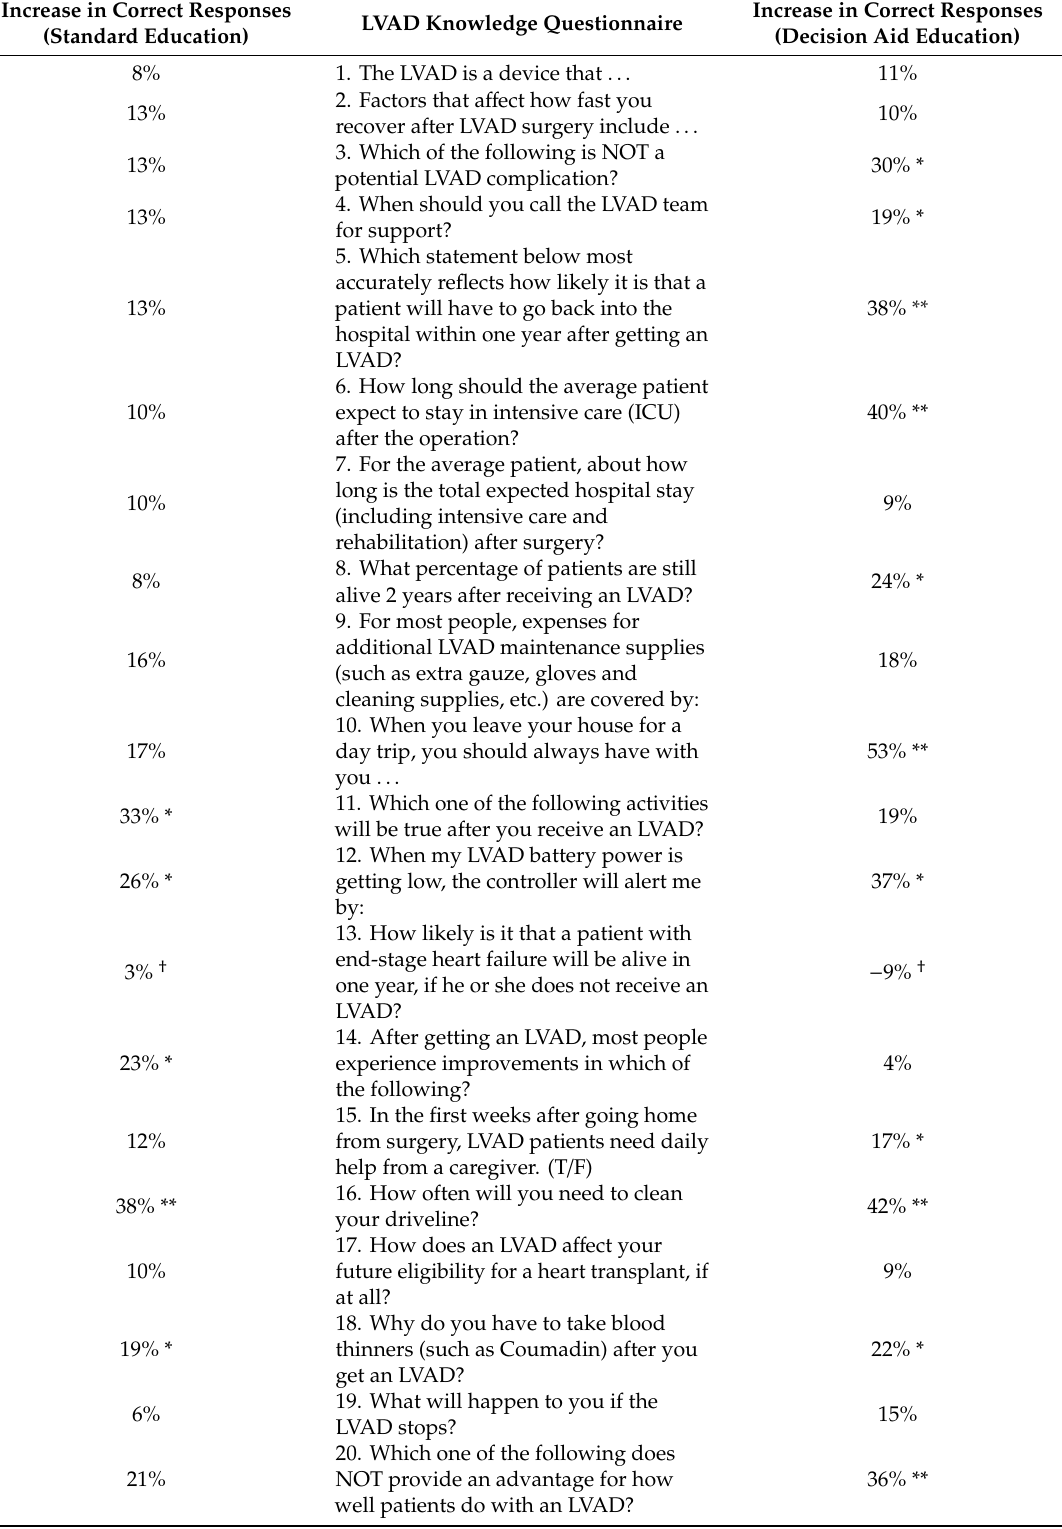
Table 3. Changes in LVAD knowledge between pre- and 1-week